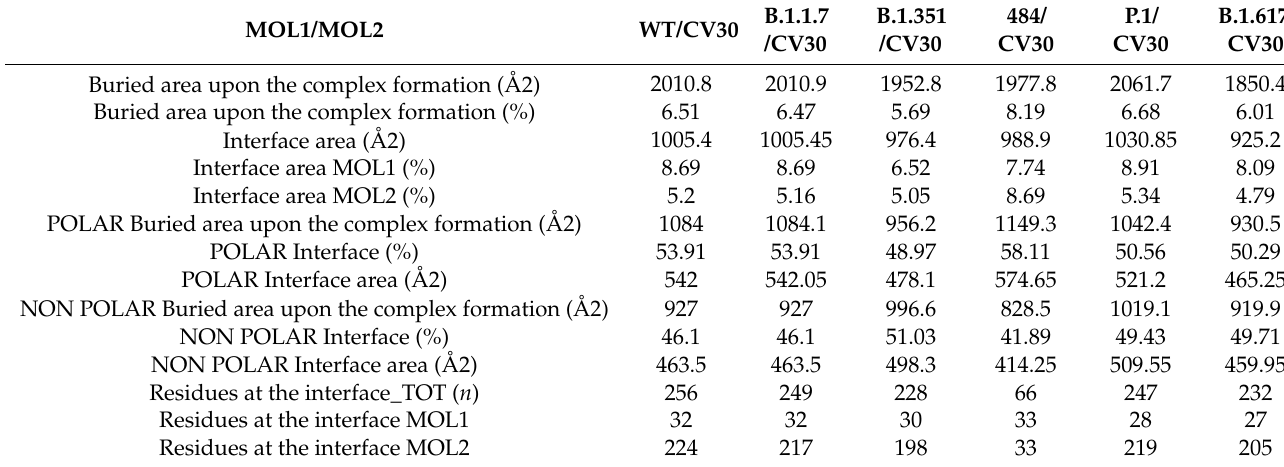
Table 2. The interaction features for the area of interfaces antibody (CV30)-spike complexes.